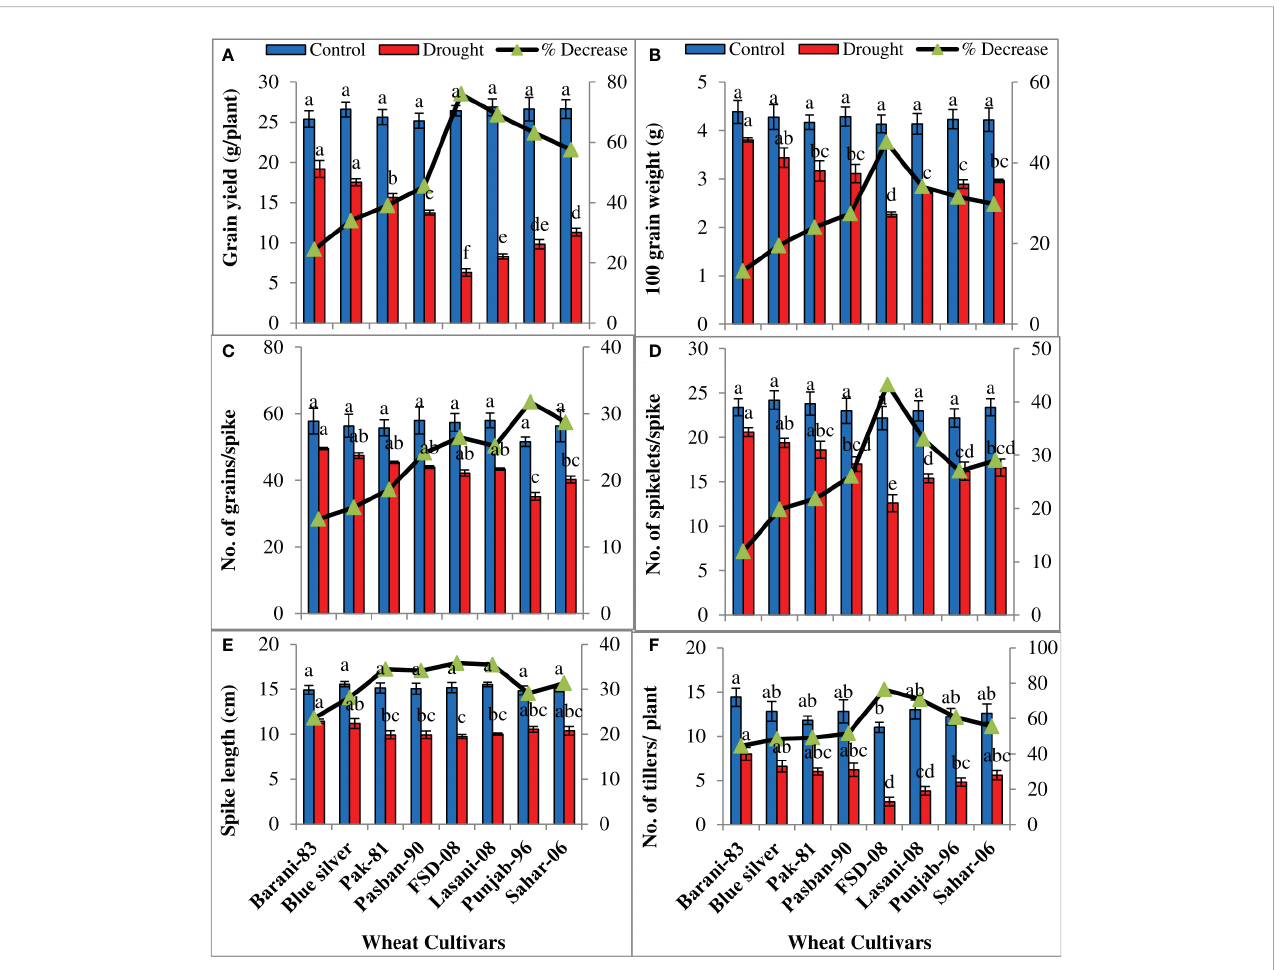
FIGURE 7 Yield attributes of selected wheat cultivars subjected to control or drought stress at adult stage. Means (± SE; n=5) are presented on the primary vertical axis, while percent decrease value is presented on secondary vertical axis. Different letters represent signi fi cant differences among cultivars at p < 0.05 according to LSD test. (A) Grain yield, (B) 100 grain weight, (C) number of grains/spike, (D) number of spikelets/spike, (E) spike length, and (F) number of